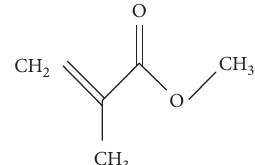
Figure 3: Molecular structure formula of methyl methacrylate.